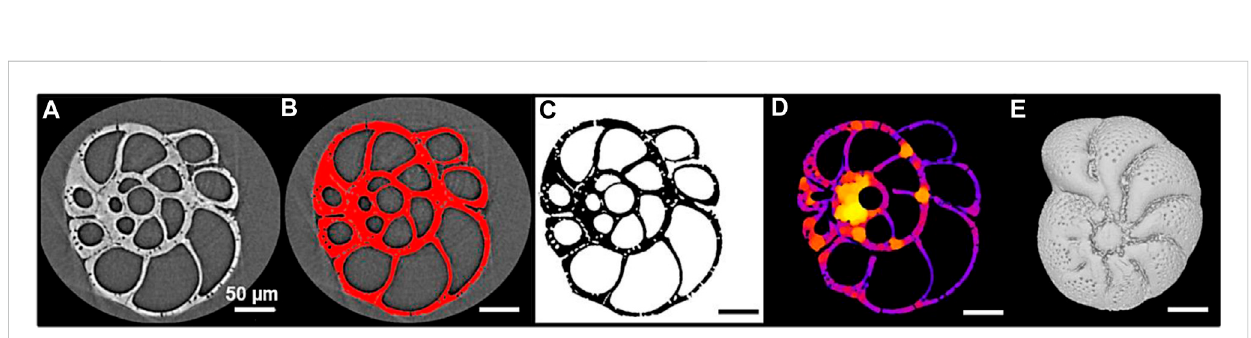
FIGURE 3 Illustrationofthestepwiseimageprocessingofan Elphidiumclavatum specimen(DV4-sp1-2005). (A) VisualizationofastackofrawimagesinFiji. (B) Segmentation of the stack in Fiji. (C) Stack of binary images resulting from the segmentation. (D) Local thickness map generated by the BoneJ plugin to calculate automatically the average thickness of the test. (E) 3D reconstruction of the test in